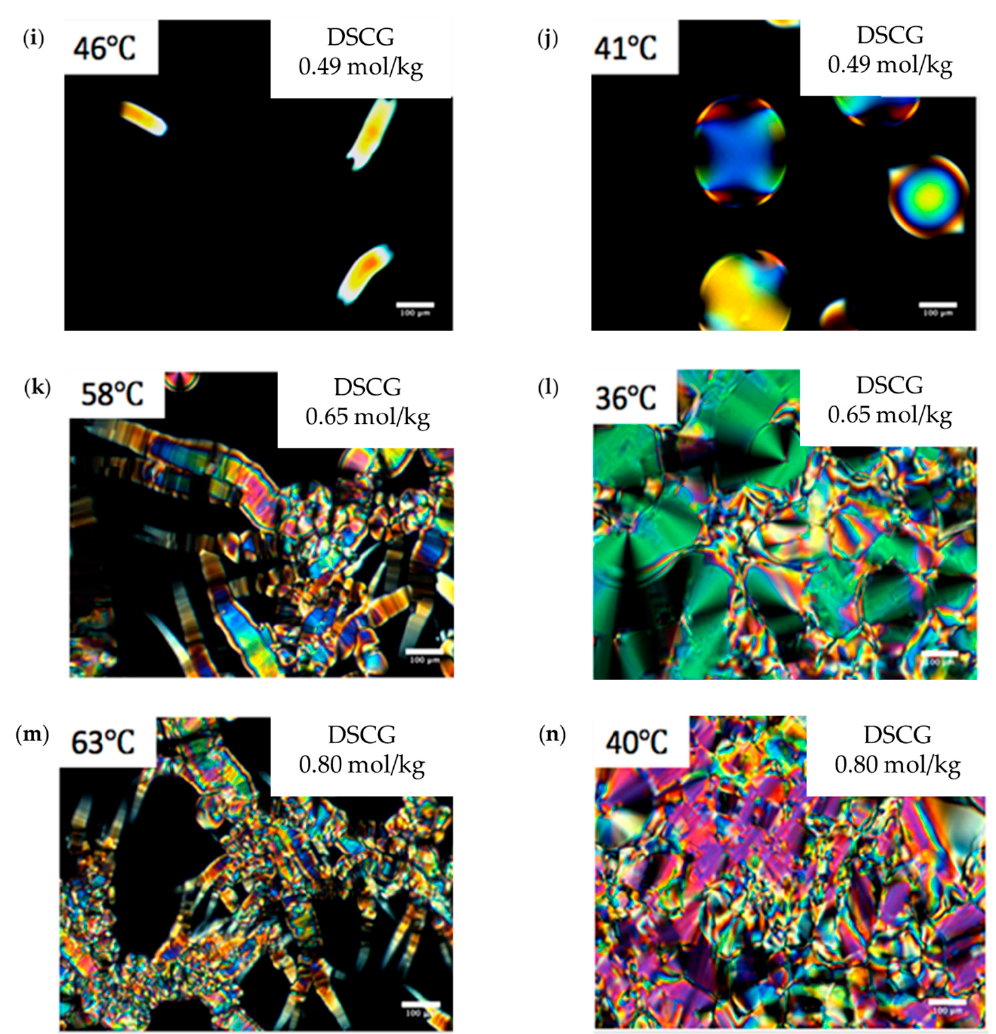
Figure 1. Phase diagram of ( a ) Mixture of 0.34 mol/kg disodium cromoglicate (DSCG) with polyethylene glycol (PEG); ( b ) Aqueous solution of pure DSCG; Optical textures of DSCG mixtures observed with crossed polarizers ( c – n ). ( c ) DSCG 0.34 mol/kg + PEG 0.011 mol/kg mixture at ( c ) T = 47.7 ◦ C; ( d ) T = 24 ◦ C; DSCG 0.34 mol/kg + PEG 0.022 mol/kg mixture at ( e ) T = 49.2 ◦